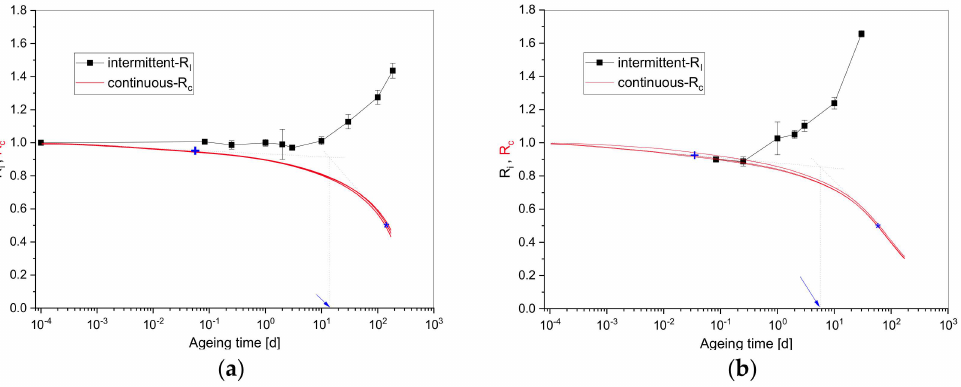
Figure 2. Continuous and intermittent normalized stress relaxation data at 125 ◦ C for: ( a ) EPDM; ( b )